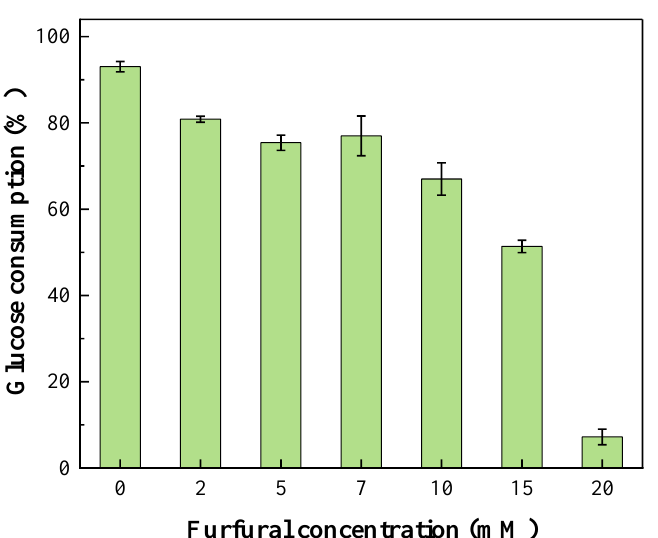
Figure 4. Glucose consumption for photo-fermentations from glucose in the absence of furfural. Glucose consumption (%) was determined as the ratio of consumed glucose (g/L) to the total input glucose (g/L).